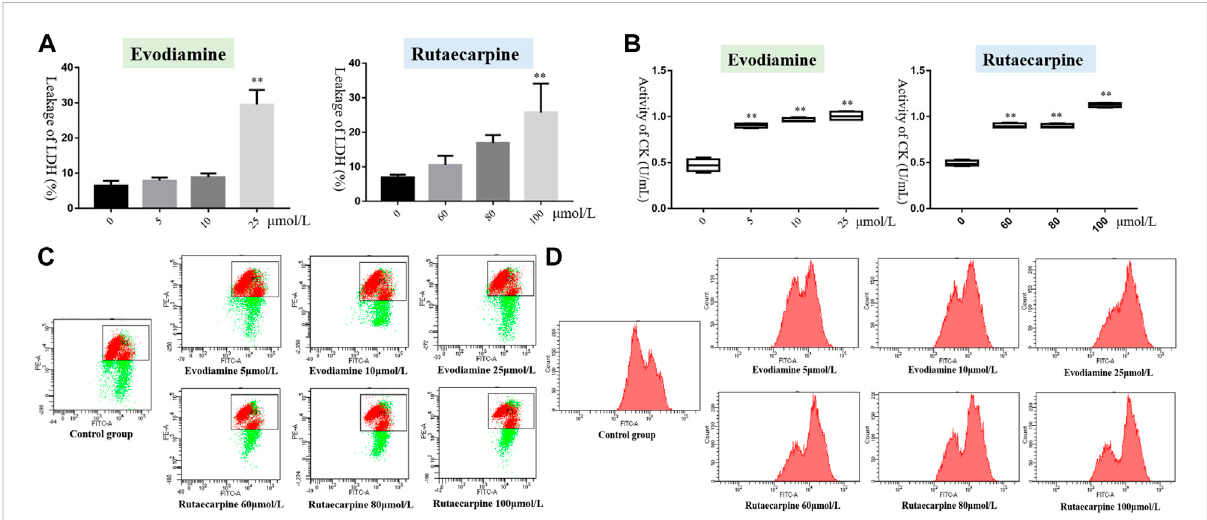
FIGURE 2 CellcytotoxicityassayofevodiamineandrutaecarpineinH9c2.Note: (A) leakageofLDH; (B) activityofCK(U/ml); (C) mitochondrialmembrane potential; (D) intensity of calcium fl uorescence.